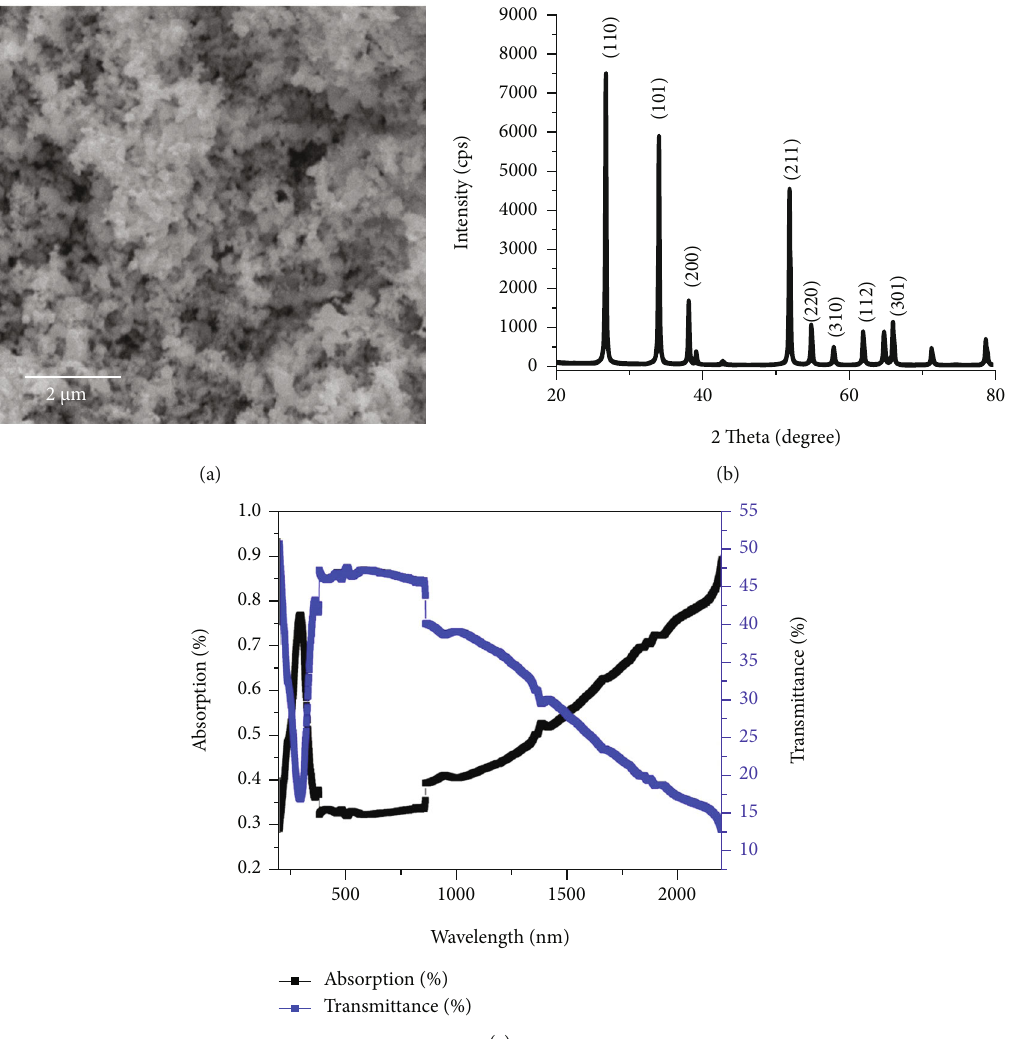
Figure 4: (a) SEM, (b) XRD, and (c) Uv-vis spectra of as received